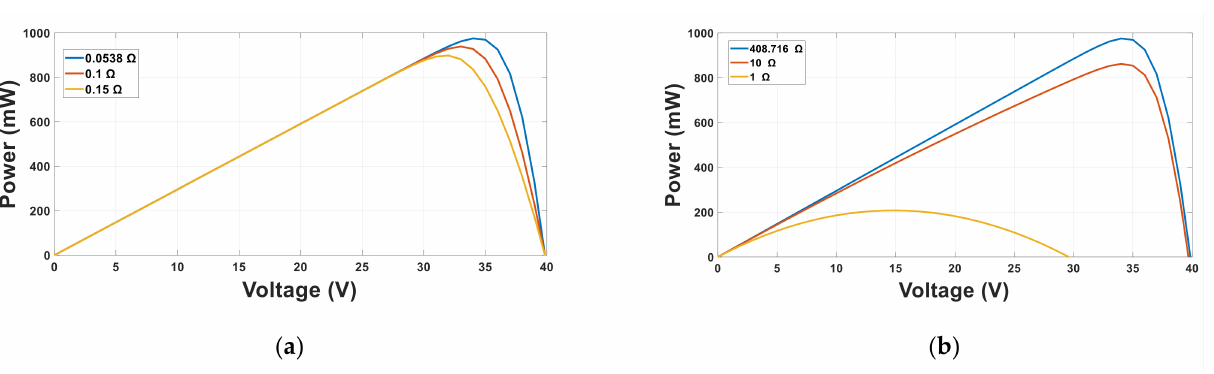
Figure 10. The impact of ( a ) series resistance ( b ) shunt resistance on the P-V characteristics of single-junction GaAs cells under AM 1.5